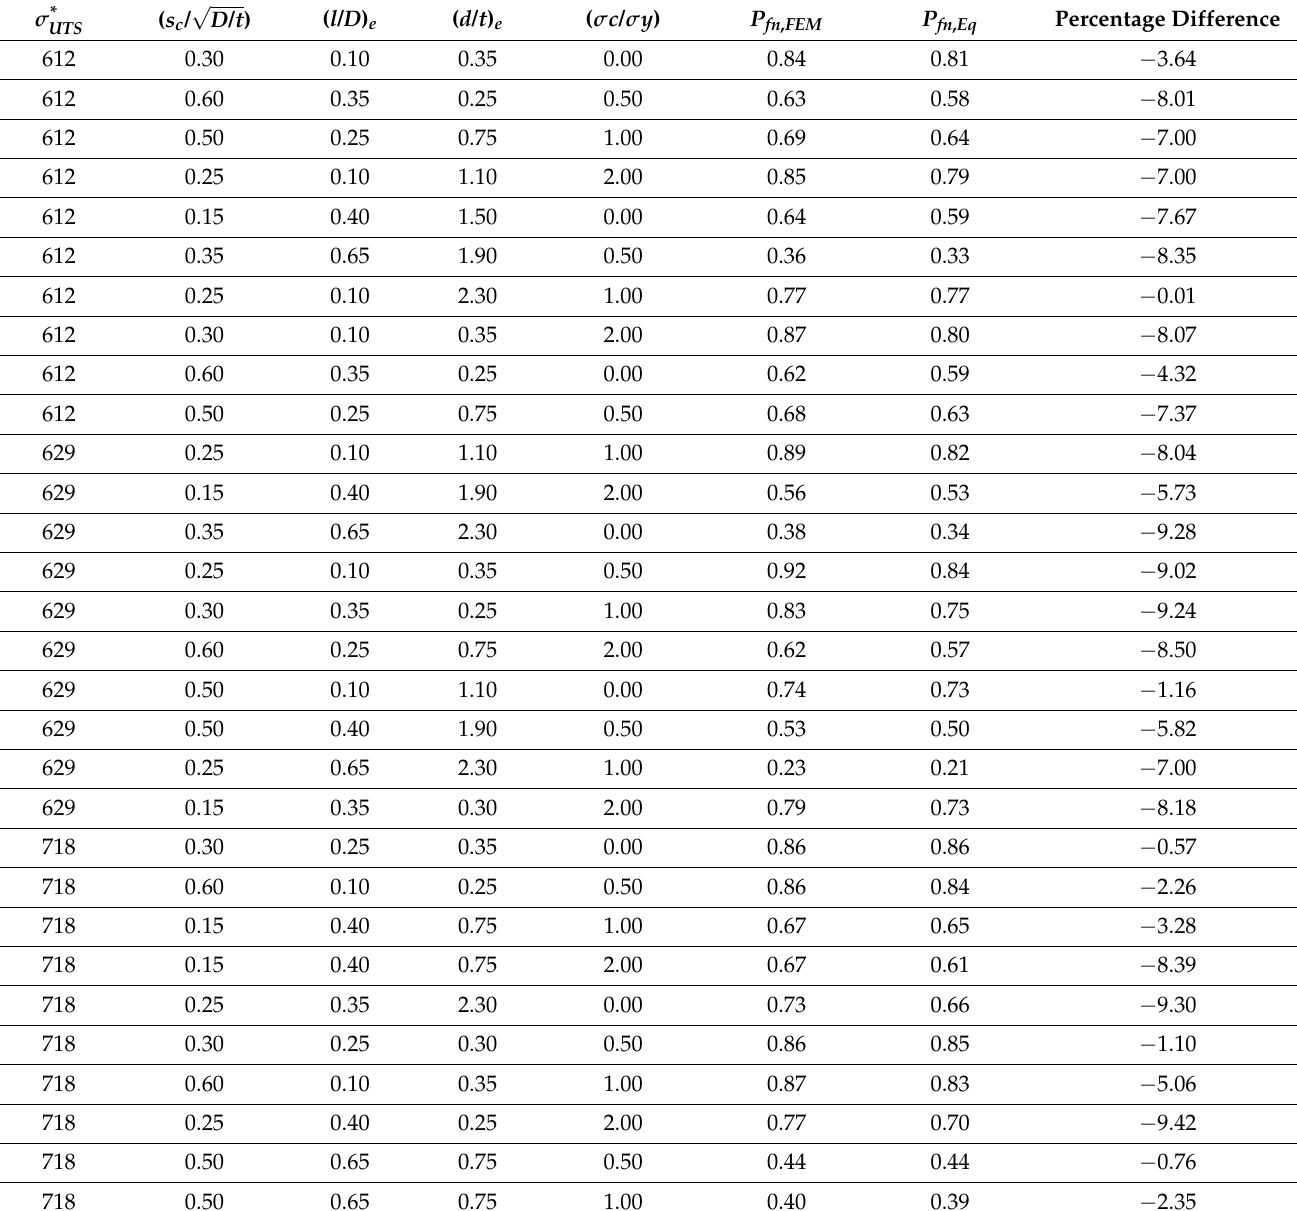
Table 10. Percentage difference between the failure pressure obtained using FEA and the developed equation for arbitrary